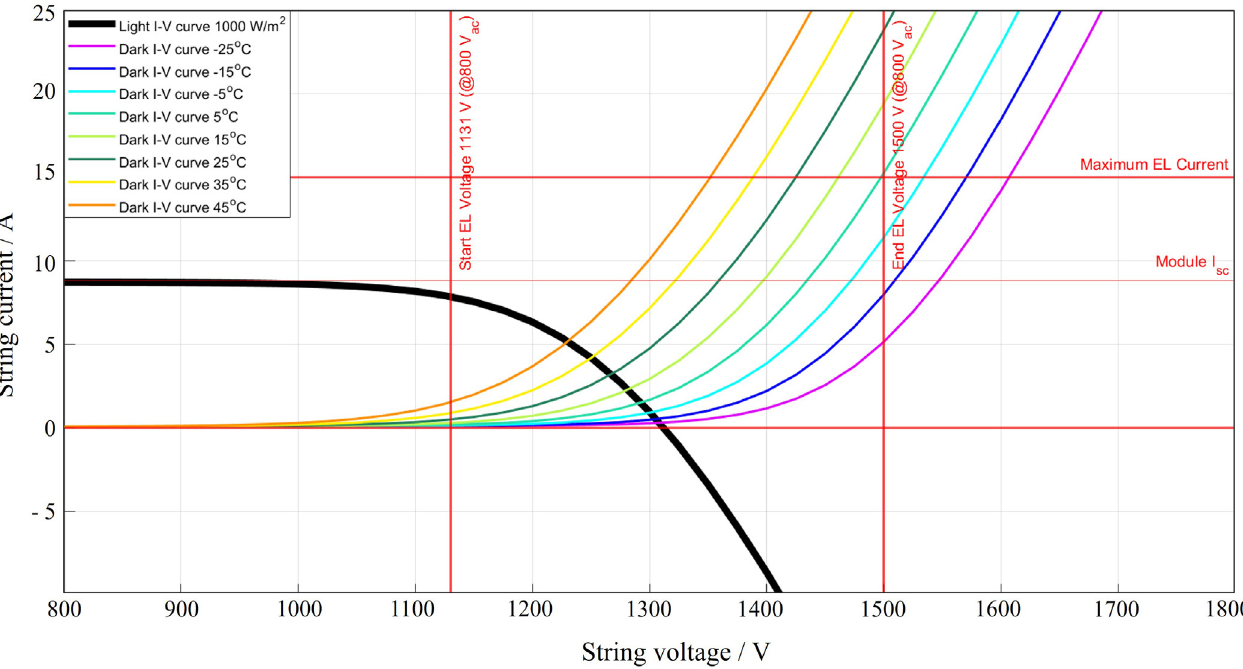
Fig. 6. I – V curves simulated for a string of 25 HJT modules in series. Light I – V at STC conditions (black thick line) and dark I – V curves simulated for temperatures between (cid:3) 25 ° C and 45 ° C. The red frame shows the EL window, in which the described HUAWEI EL-ready inverter is able to